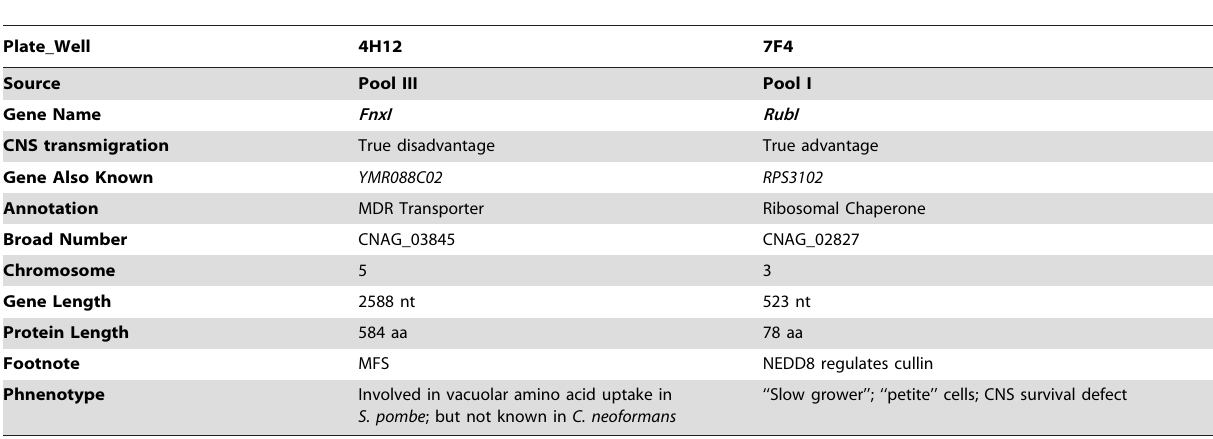
Table 3. Characteristics of two novel genes related to CNS